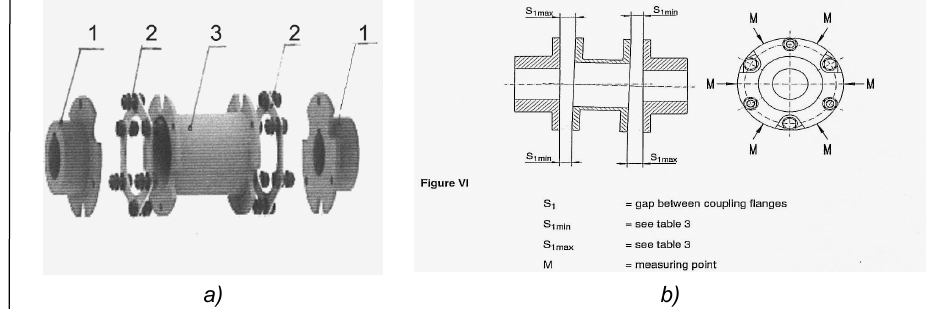
Figure 19 – Display of flexible couplings ARPEX Flender series K 430 sizes 80 to